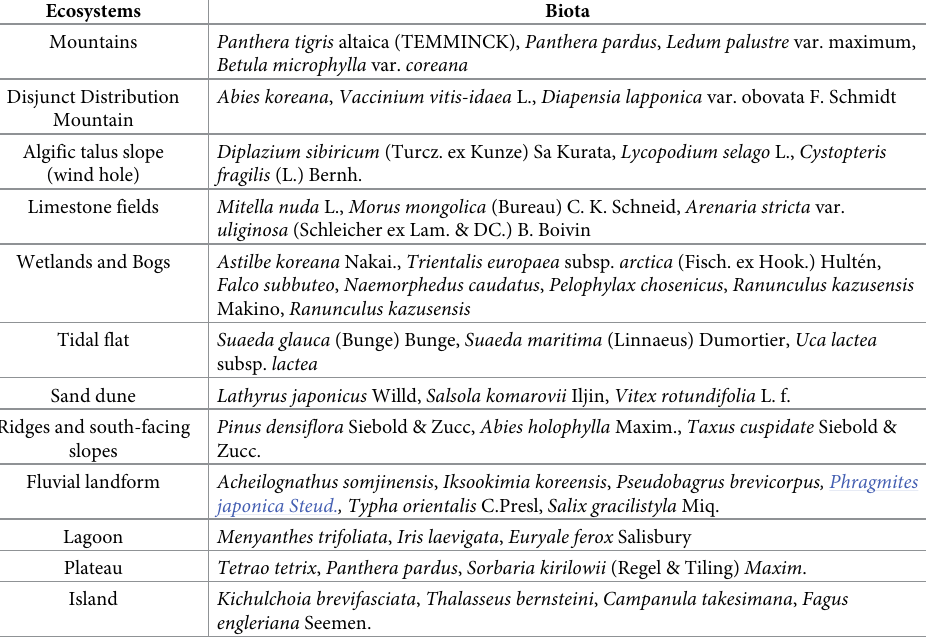
Table 1. Major ecosystems and biota of the Korean Peninsula (sources: National Ecosystem Survey and DPRK Flora and Fauna of Coreana